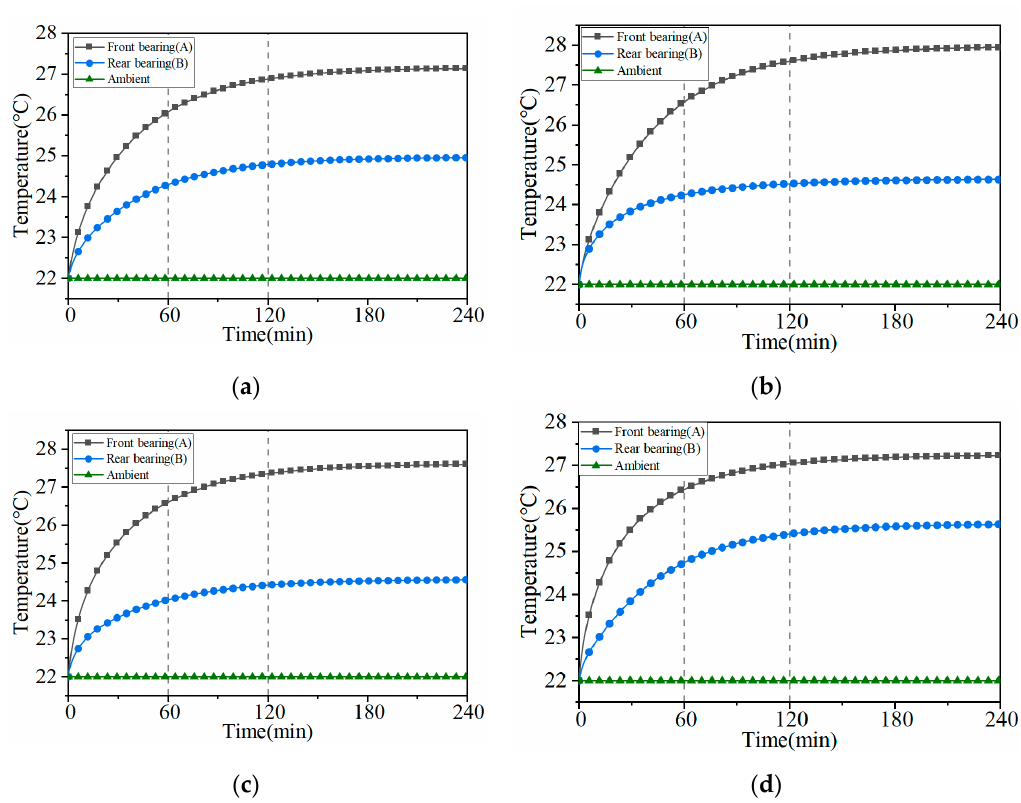
Figure 14. Simulation results of the node temperature of the ball screw feed system under different working conditions: ( a ) working condition 1; ( b ) working condition 2; ( c ) working condition 3; and ( d ) working condition 4.